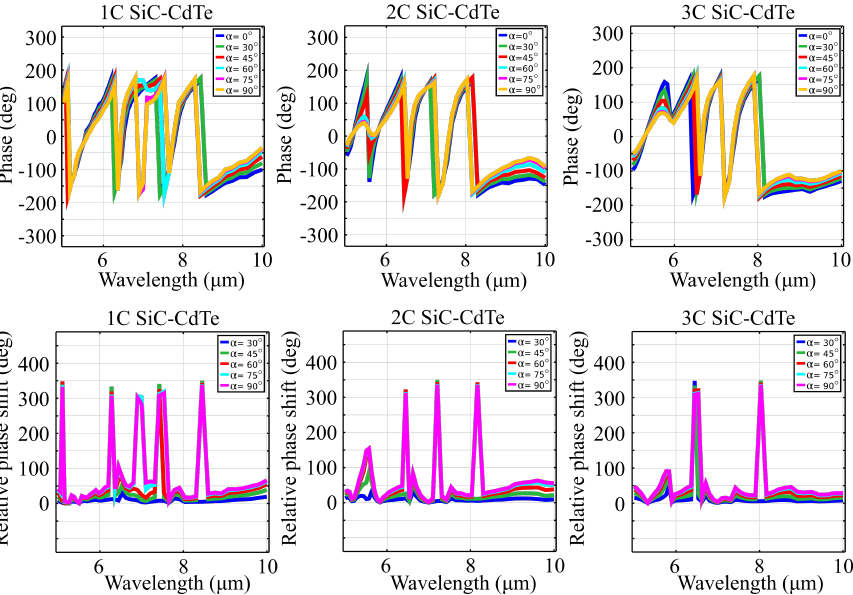
Figure 3. Absolute phase (top row) and relative phase shift (bottom row) spectra of the reflected wave after interaction with structures 1C, 2C and 3C at different input linear polarization states described by angle α . All configurations exhibit full 2 π phase wavefront control and full phase-polarization dichroism for specific